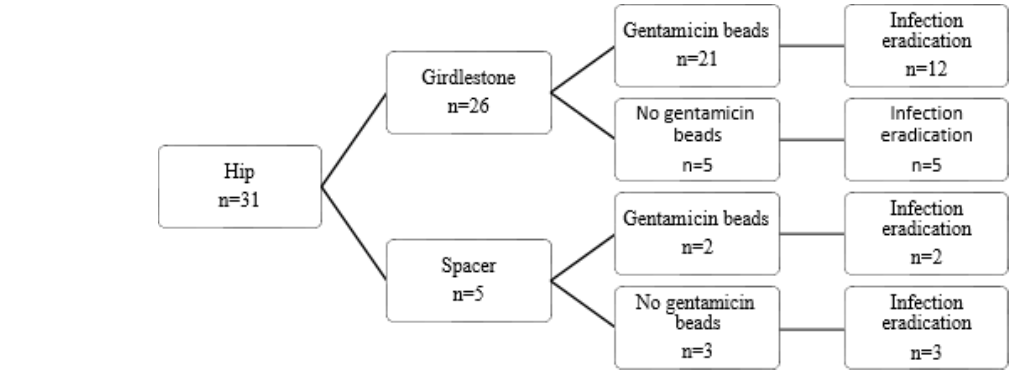
Figure 1. Flow diagram of treatment strategy and infection eradication for patients treated for PJI of the hip.